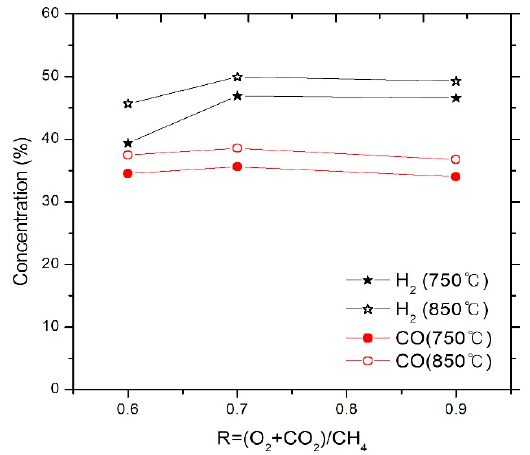
Figure 10. E ff ect of R = ((O 2 + CO 2 ) / CH 4 ) values on syngas